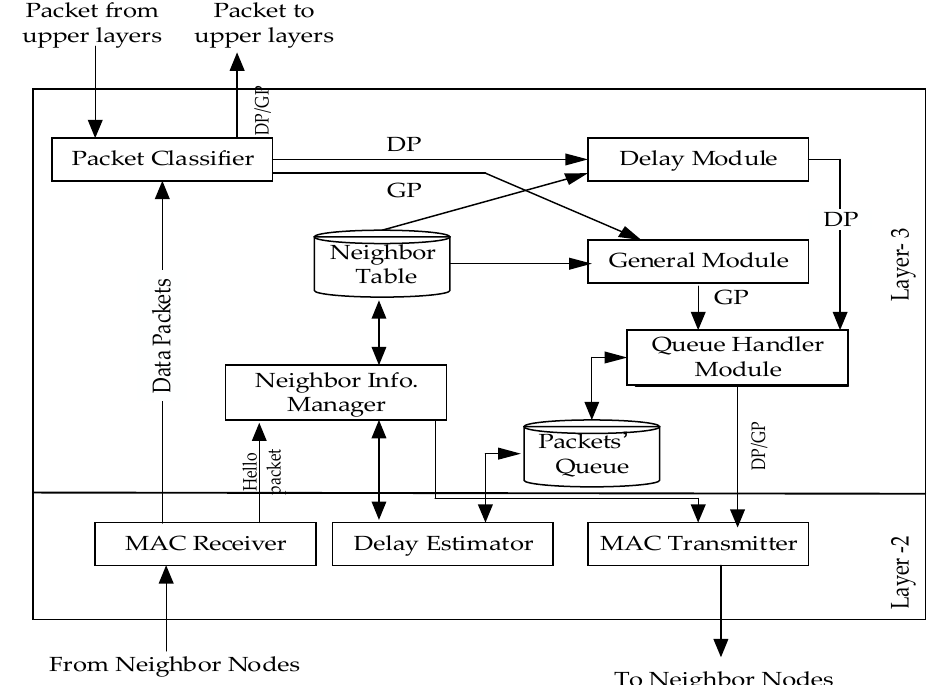
Figure 12. Modular diagram of the LRPD protocol.